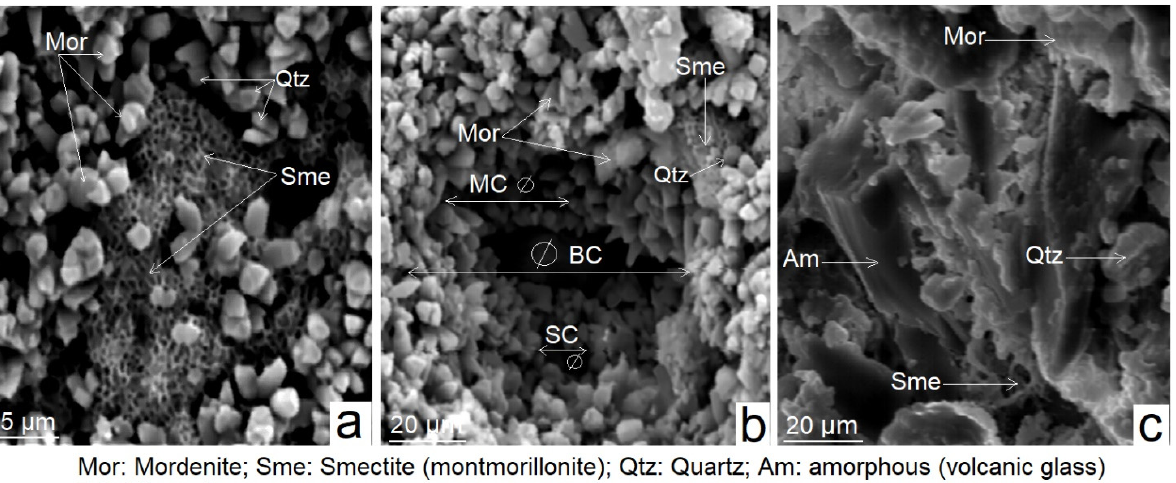
Figure 2. Microphotographs ( a – c ) of the ZCT sample, obtained through scanning electron microscopy (SEM).